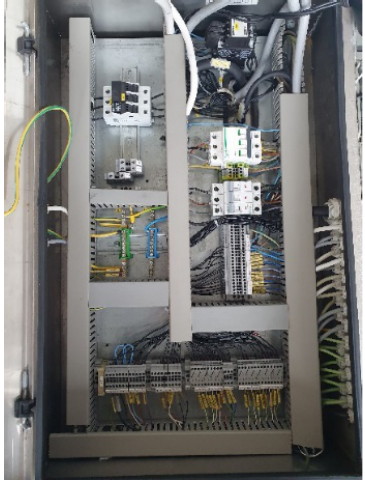
Figure 12. Local CPU connections.